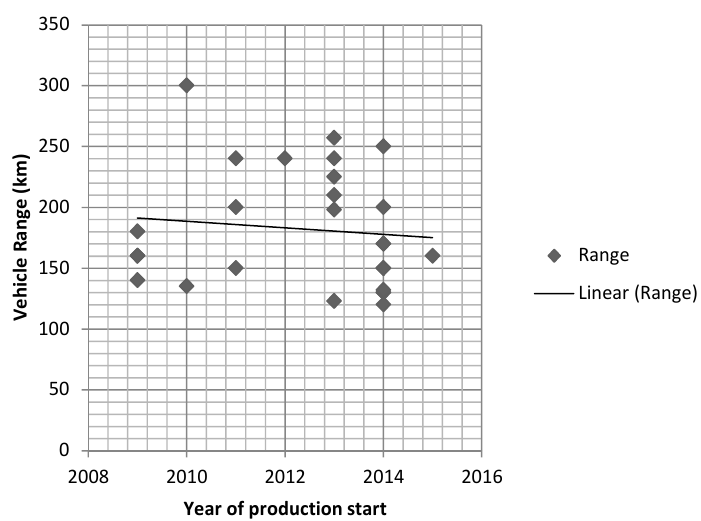
Figure 3. Category III range evolution.